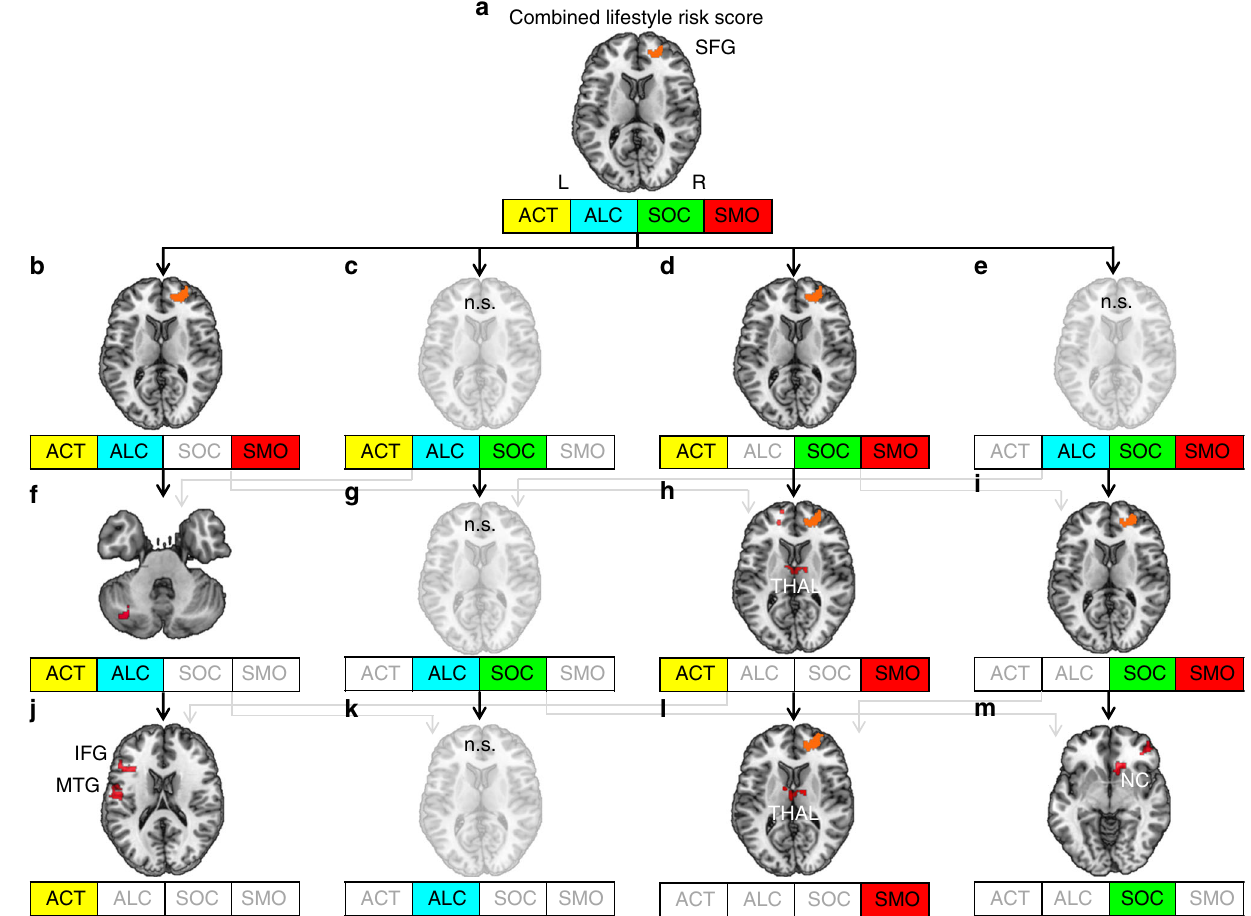
Fig. 4 Lifestyle risk-associated increases in resting-state functional connectivity (RSFC) to the seed in right ventro-lateral prefrontal cortex (vlPFC). a – m Transversal sections show brain regions exhibiting increases in RSFC depicted in red. The recurrent pattern of higher RSFC between right vlPFC and superior frontal gyrus is outlined in orange. Arrows indicate the work fl ow of the stepwise exclusion. This analysis included a subsample of the study population ( n = 501). For other conventions, see Fig. 2. Results were signi fi cant at α = 0.05 (cluster level corrected, cluster-forming threshold α = 0.001).